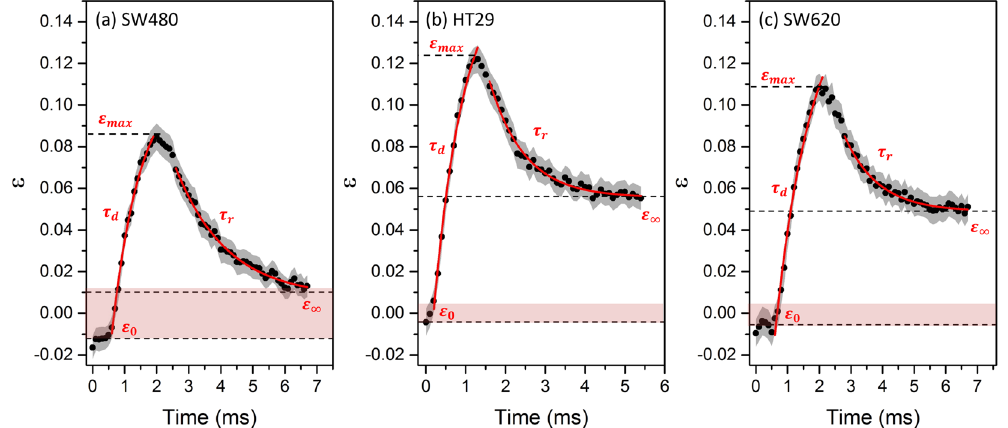
Figure 3. Strain ε was tracked for the three CRC cell types as a function of time, with the standard error shown by the grey shaded areas. Q was fixed at 5 µ l/min and the suspension medium viscosity was 33 cP. The final strain is marked by dashed lines ε ∞ ( ) , found by extrapolation of a exponential fit to the relaxation (red line). ( a ) The averaged deformation trace of N = 56 SW480 cells. ( b ) The averaged deformation trace of N = 49 HT29 cells. ( c ) The averaged deformation trace of N = 50 SW620 cells.